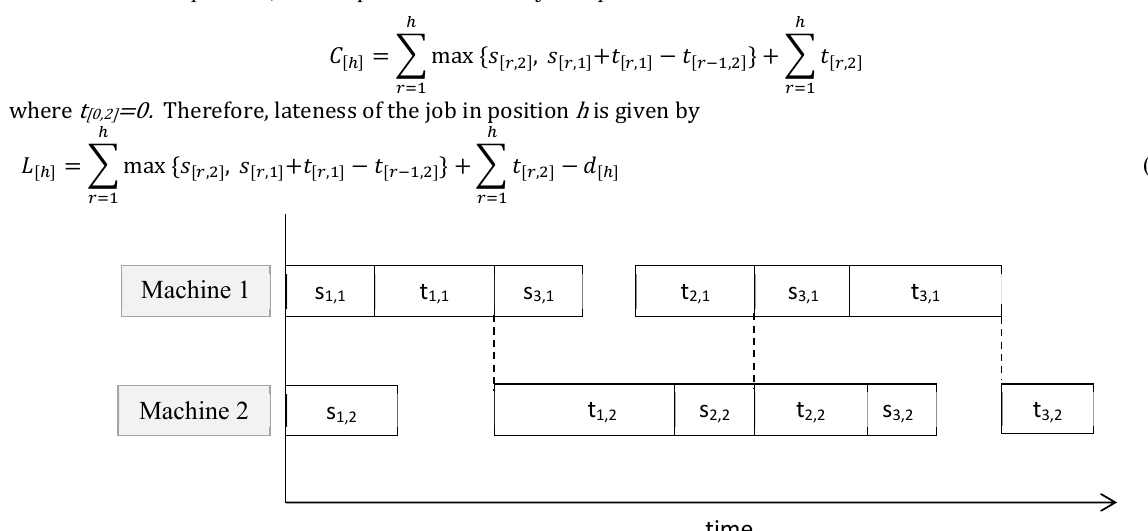
Fig. 1. A three-job two-machine